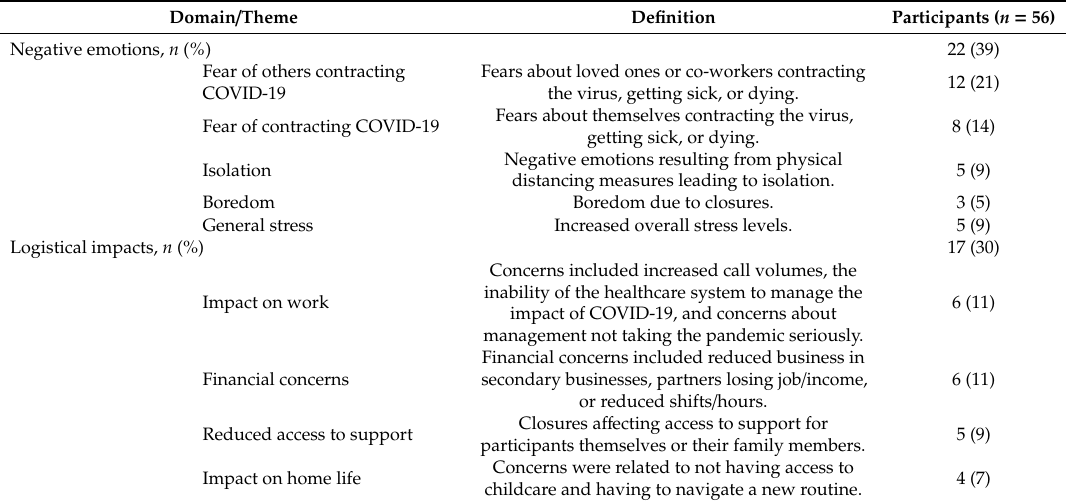
Table 4. Results of qualitative analyses of telephone screens concerning impacts of